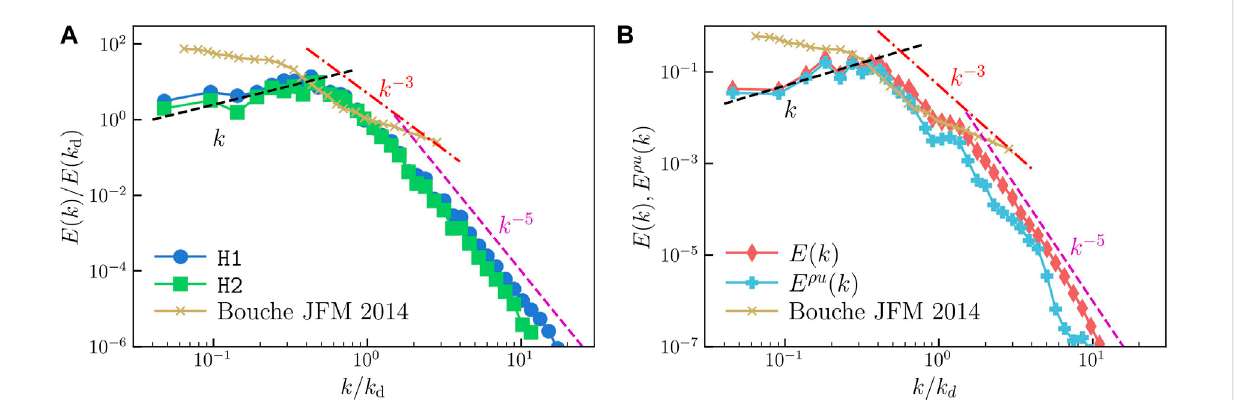
FIGURE 4 (A) Log-log of the energy spectra [ E ( k ) versus k ] for low At runs H1 and H2 . (B) Log-log plot of the energy spectra ( E ( k )) and cospectra ( E ρ u ( k )) for high At =0.9 run H 3(Ga=274, ϕ =0.05). We overlay thedata extracted from Bouche etal. [15]in boththeplots for comparison.The experimentaldata isscaled vertically for clarity. The data is extracted using the Enguage digitizer [25].